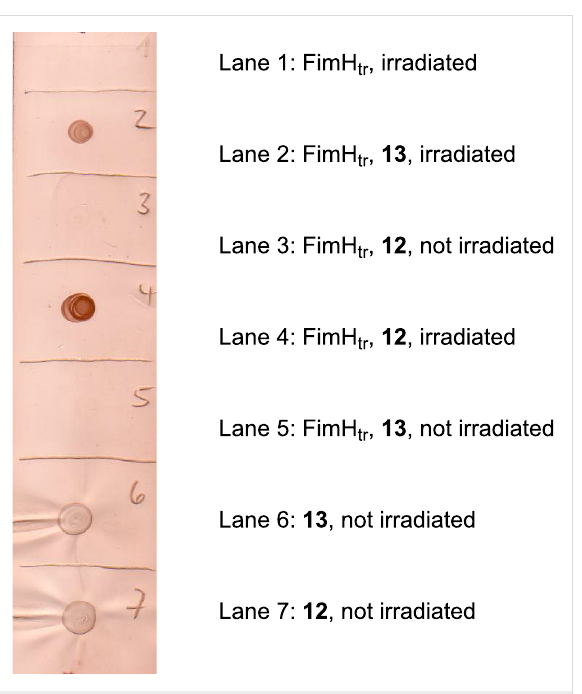
Figure 3: Affino dot–blot with FimH tr and photoactive mannosides applied to nitrocellulose disks. It was irradiated, incubated with strepta- vidine–HRP conjugate and stained by addition of the chromogene 3,3’- diaminobenzidine. Photoaffinity probes 12 (lane 4) and 13 (lane 2) led to different color intensities, suggesting that ligand 12 is bound more tightly to FimH tr than ligand 13